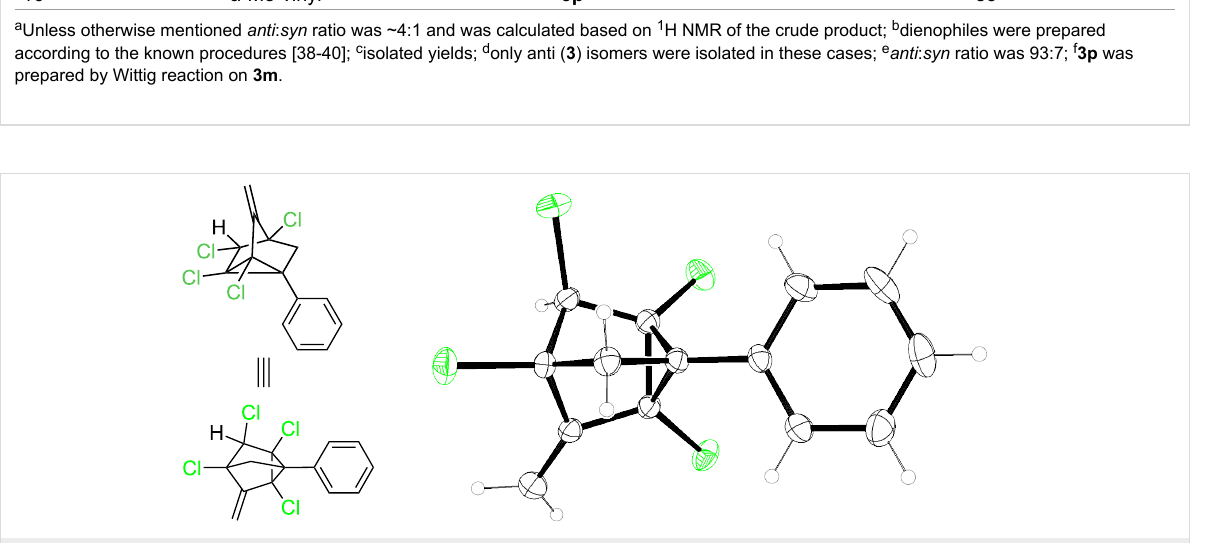
oxide is better in DMSO compared to other solvents [16].